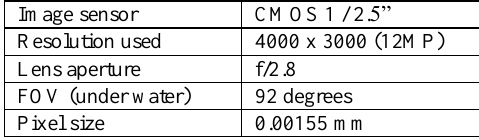
Table 1. Specifications of GoPro Hero 3+ (Black series).